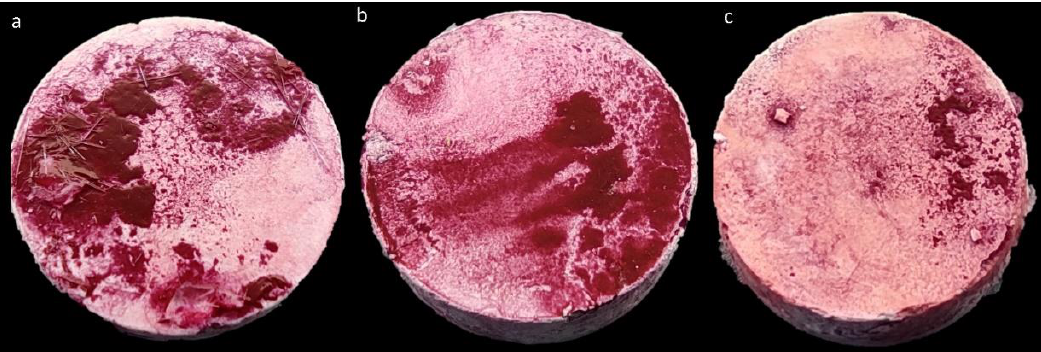
Figure 4. Biofilm of Staphylococcus aureus ATCC 6538 formed on the hydroxyapatite disc in three culture media: a tryptic soy broth TSB ( a ), tryptic soy broth with 1% glucose TSB + G ( b )